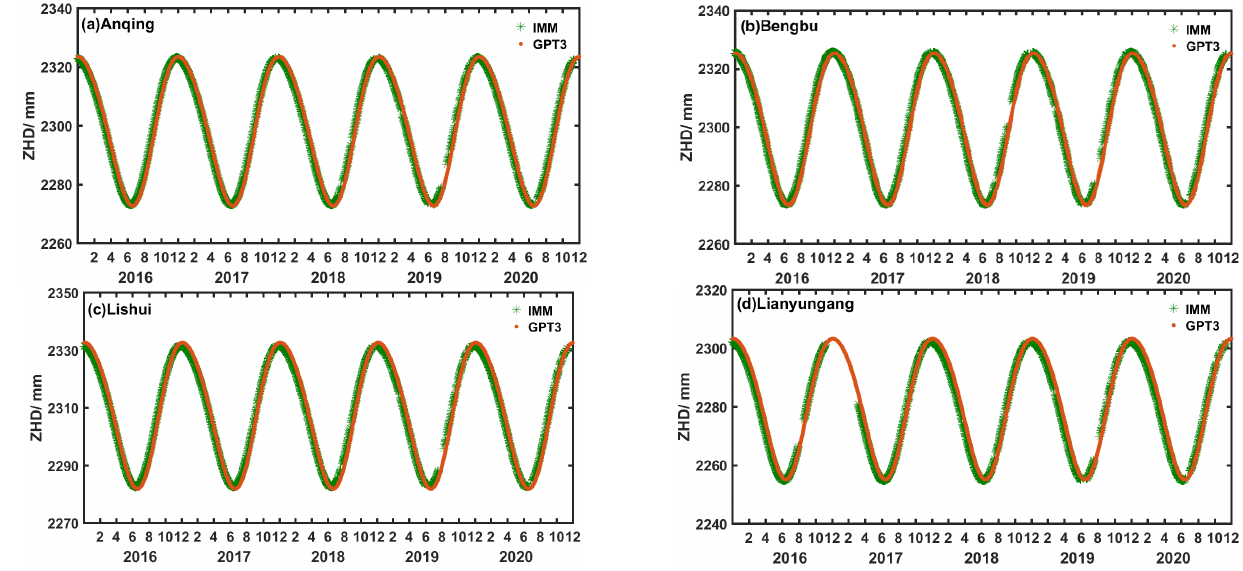
Figure 2. The seasonal variations of ZHD in Anqing ( a ), Bengbu ( b ), Lishui ( c ), and Lianyungang ( d ) during 2016–2020.